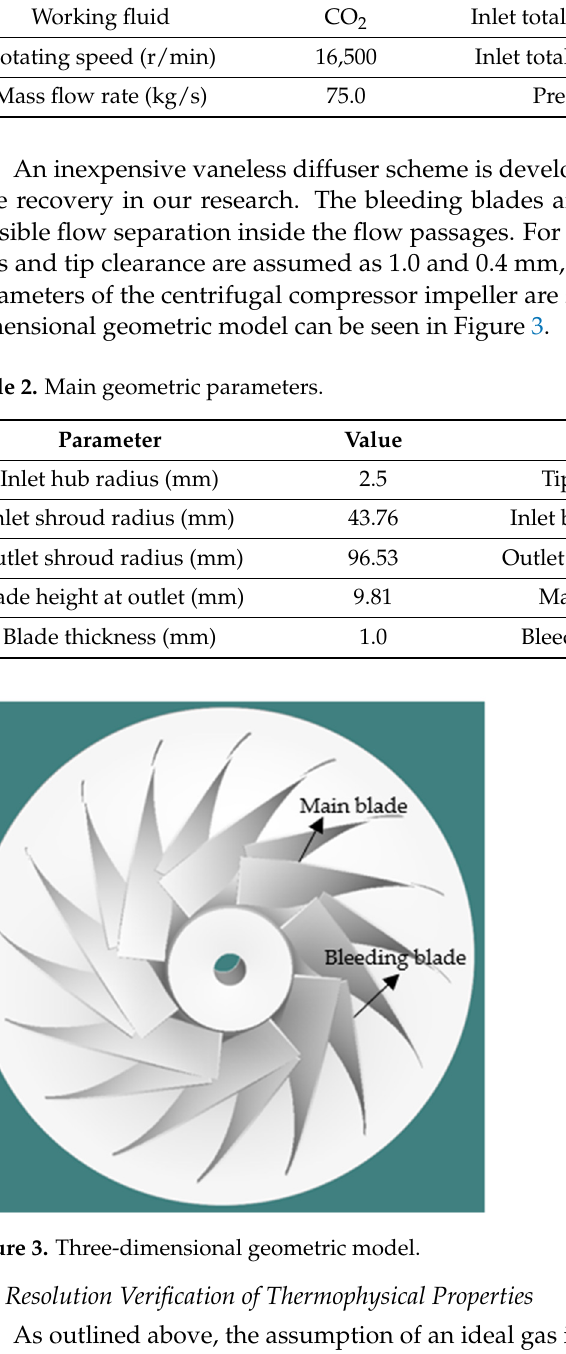
Table 1. Design specifications.